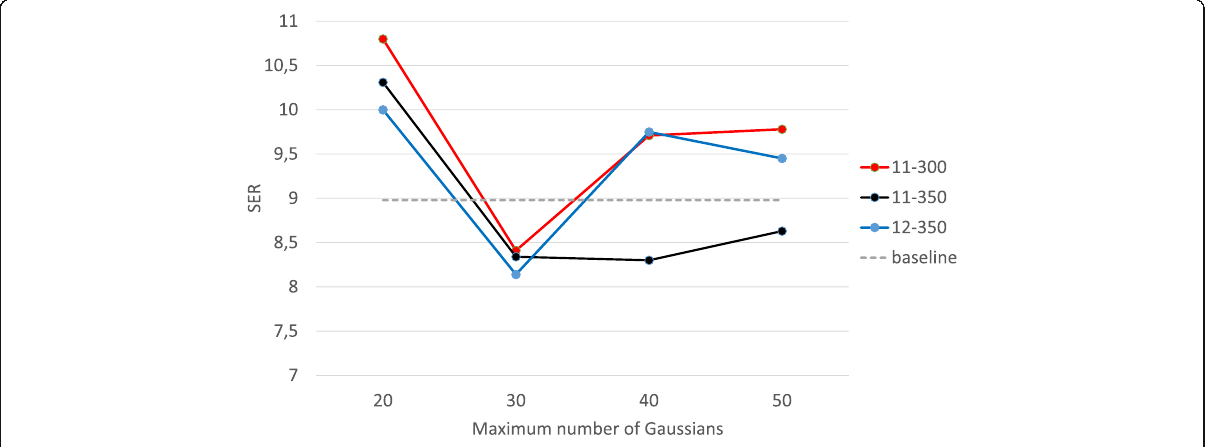
Fig. 15 SER for the DEVELSET for a single mfcc stream across different values maximum number of Gaussians and other parameters such as number of Gaussians per cluster (parameter A) and minimum duration of a speaker